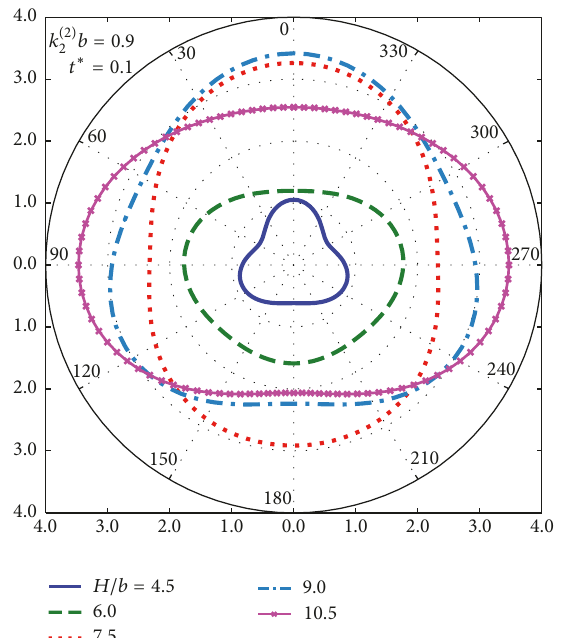
Figure 14: Tangential stress (𝜎 ∗ 𝜃𝜃 ) versus polar angle at 𝑟 = 𝑏 for different depths (𝐻/𝑏) for a tunnel in hard soil.